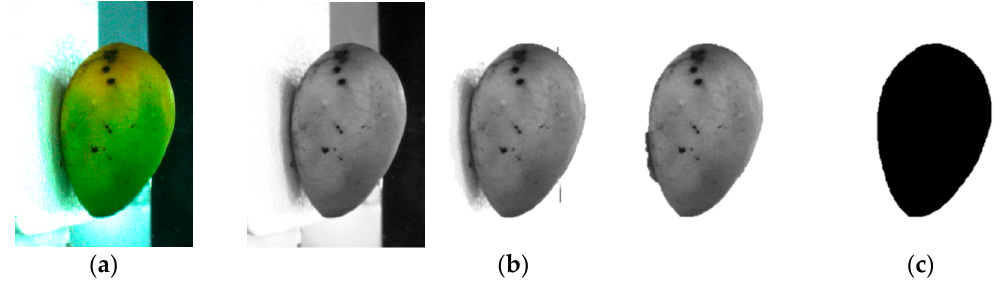
Figure 5. Image processing step involves in background removal for side view image. ( a ) Original RGB image; ( b ) Process of background removal by multi-stage global threshold; ( c ) Binary image.